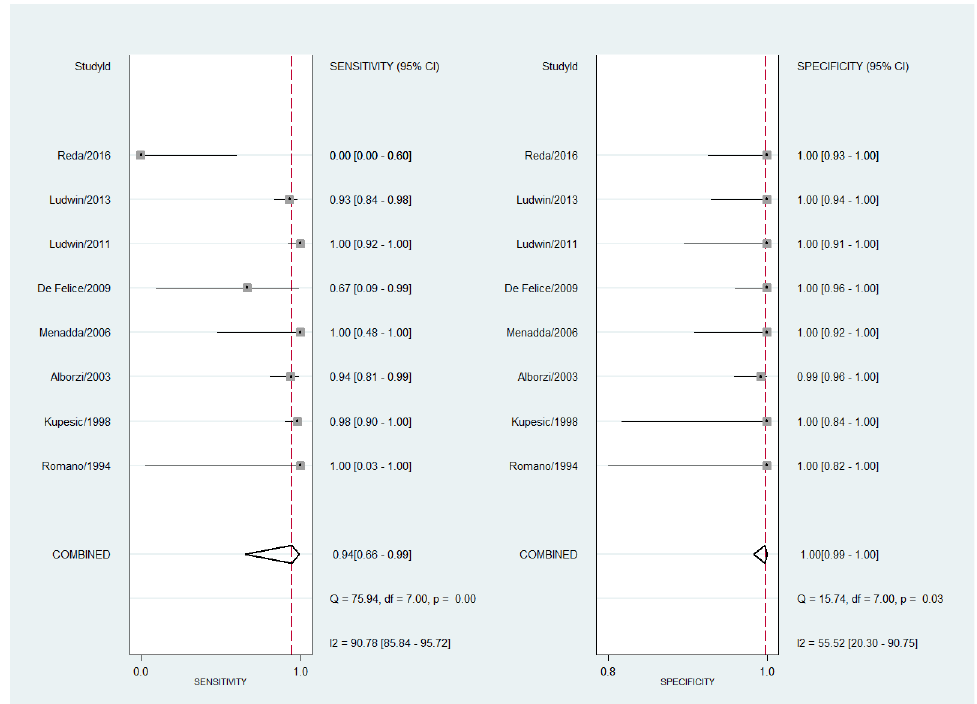
Figure 3. Forest plot for sensitivity and specificity for all studies concerning the diagnostic perfor- mance of two-dimensional sonohysterography for uterine septum detection mance of two-dimensional sonohysterography for uterine septum detection [ 13,23,24,27,28,29,31,36] .